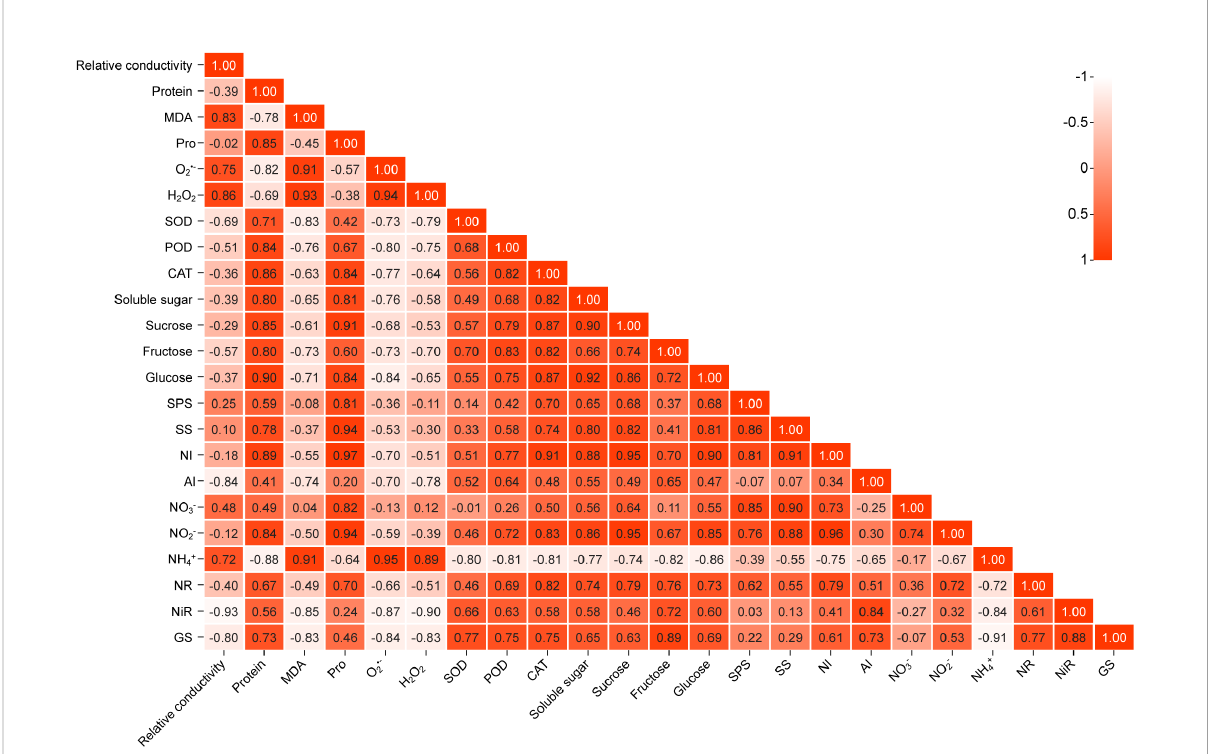
FIGURE 8 Correlation diagram of correlation of three indicators. Positive values indicate positive correlation, while negative values indicate negative correlation. The darker or lighter the color, the stronger the correlation between the indicators. All correlations in the fi gure re fl ect the absolute value of the Pearson correlation coef fi cient above the threshold ( P< 0.05, P<